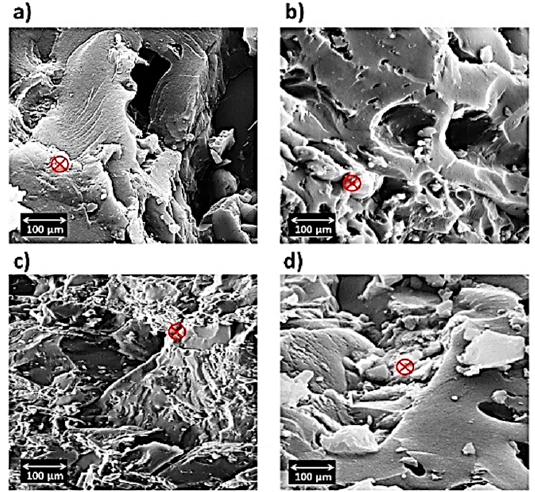
Figure 14. SEM images of immersed ( a ) alloy and composites ( b ) C1, ( c ) C2 and ( d ) C3 after 30 days.